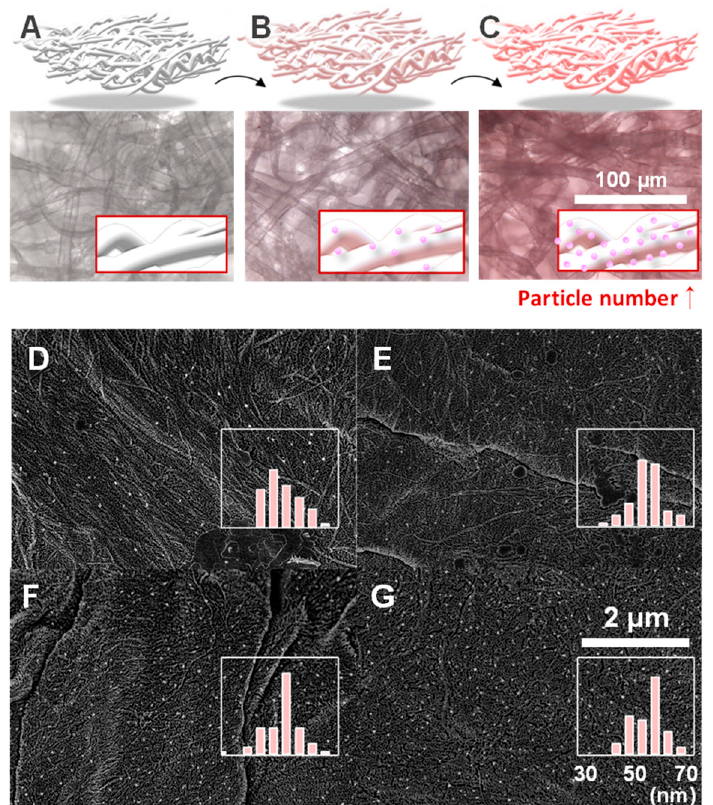
Figure 2. Gold nanoparticle formation on cellulose surfaces. ( A ) Paper cellulose can make bonds with ( B ) gold nanospheres, when reduced the paper subsequently demonstrates pink coloration, which indicates ( C ) the increasing number of nanosphere while it keeps staying in the small size; SEM images and the morphologic characteristics of the gold nanospheres synthesized at low glucose concentrations of ( D ) 0.5 mM, ( E ) 1 mM, ( F ) 2 mM and ( G ) 9 mM, in which histograms gained from SEM analysis showing homogeneousness of the nanospheres.